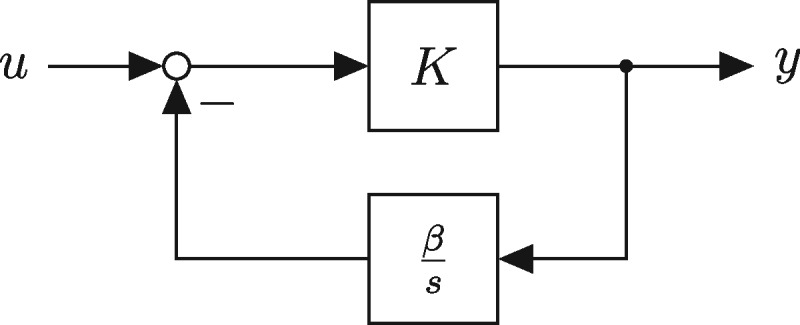
Ideal approximation of a differentiator, from (4).